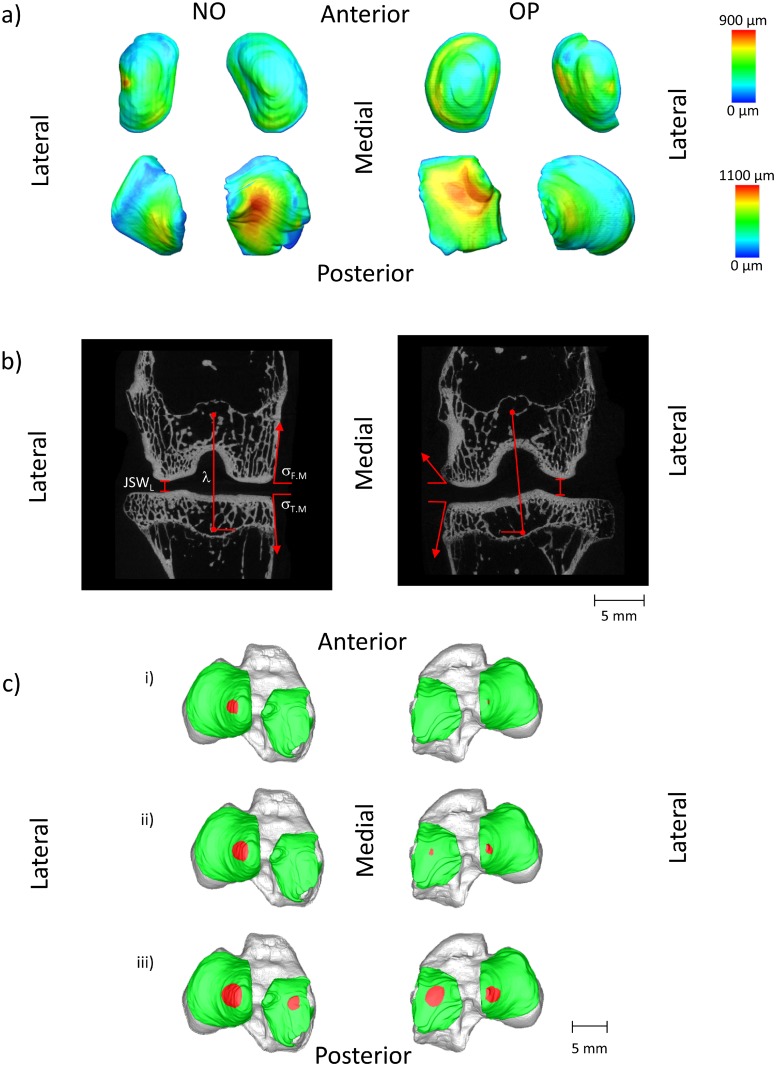
Typical examples of 3D QMA showing differences between OP and NO joints.(a) Thickness maps of top: femoral, and bottom: tibial cartilage compartments indicating increased Cg.Th in OP medial and lateral femoral compartments, and medial tibial compartment, as well as increased Cg.S and Cg.V in OP medial femoral condyle, and increased Cg.S in lateral tibial plateau. (b) Larger JSW, smaller α angle, and more acute medial σ angles are evident in the OP joint. (c) Upon virtual loading of the femur onto the tibia in a stepwise manner (i) the distance to reach first contact, χ - indicated in red—is significantly higher in lateral OP compartments compared to NO. (ii) and (iii) Once contact is reached, rate of increase, m, rises significantly faster in medial OP compartments.